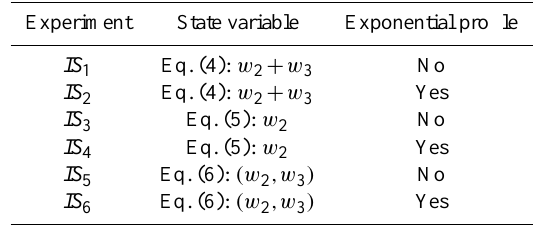
Table 2. Definition of the six different experiments assessed for the assimilation of real observations. IS stands for “Initial States”, because these states will be used as initial states for the Ensemble Streamflow forecasts in the future.